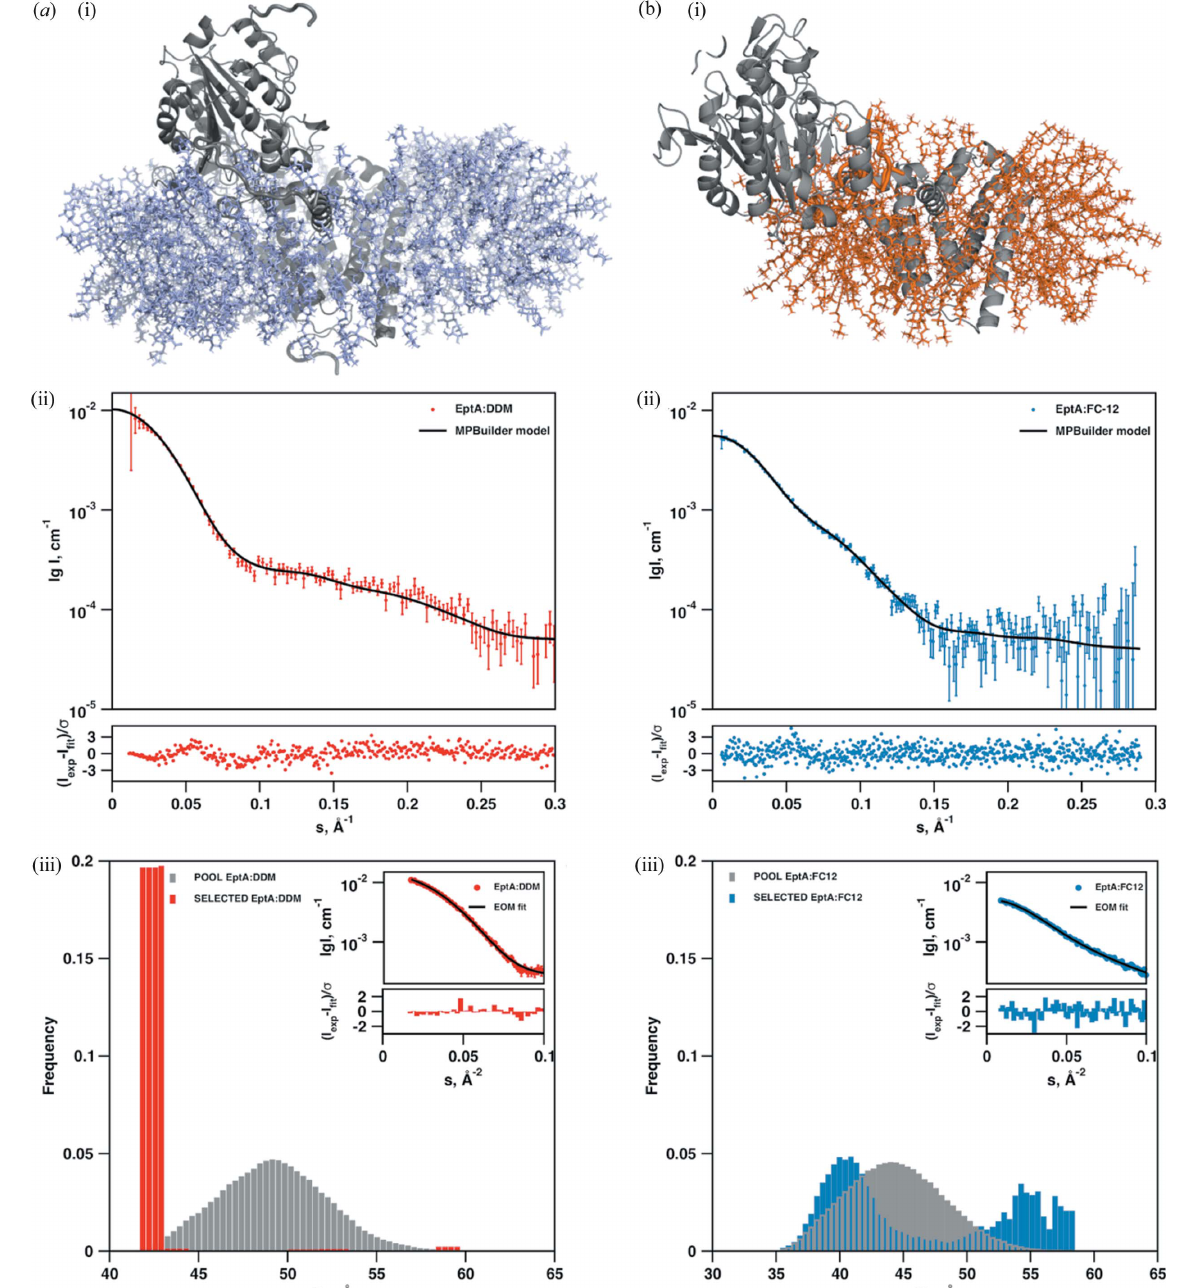
Figure 4 Hybrid SAXS modelling results and flexibility analysis. Results for the ( a ) EptA:DDM complex and ( b ) EptA:DPC complex. (i) Hybrid SAXS models generated for each of the complexes using the combined MPBuilder / PACKMOL / CORAL approach. The atomic structure of EptA is represented in cartoon mode and coloured grey. The detergent corona around EptA is represented as pale blue and orange coloured lines for DDM and DPC, respectively. (ii) Comparison of the SAXS experimental data (coloured red and blue for EptA:DDM and EptA:DPC, respectively) with the scattering curves computed from the best fitting hybrid models (black solid line). The lower insets show the error-weighted residual difference plot for the fits. (iii) Flexibility analysis of the complexes using the EOM . Distance profiles ( R g ) of the random pools of PDC conformations generated (grey histograms) and of the selected ensembles of conformations that best fit the SAXS data (red and blue histograms for EptA:DDM and EptA:DPC, respectively). The fits of the selected ensembles to the experimental data and residuals are shown in the inset. For EptA:DDM the selected ensemble consists of a narrow population of similar compact conformations, and two wide populations of both compact and extended conformations are selected for EptA:DPC, indicating significant conformational